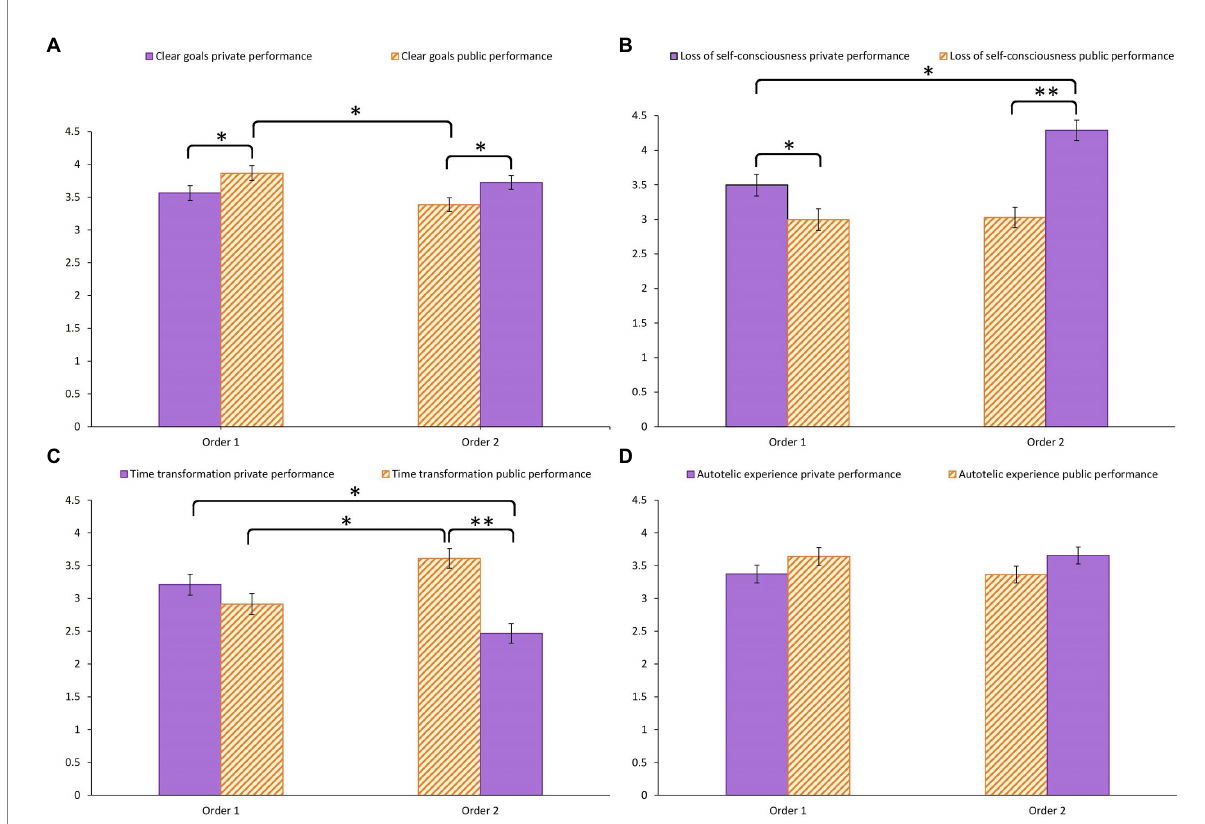
FIGURE 2 Model-predicted marginal means for order 1 (private session performed first then public session) and order 2 (public session performed first then private session) (A) “Clear goals,” (B) “Loss of self-consciousness,” (C) “Transformation of time,” and (D) “Autotelic experience.” The symbol “*” indicates a value of p below 0.05 and the symbol “**” indicates a value of p below